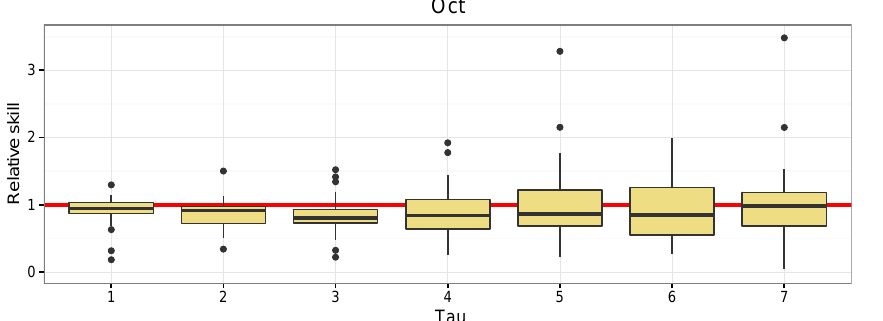
Figure 10. Box plots of relative skill, as defined by Eq. (32), for October, and τ = 1 ,..., 7. The vertical axis is truncated at 3.5, leaving two RS values not shown. Values above 1 indicate that ˆ p v gives better forecasts than ˆ p z .